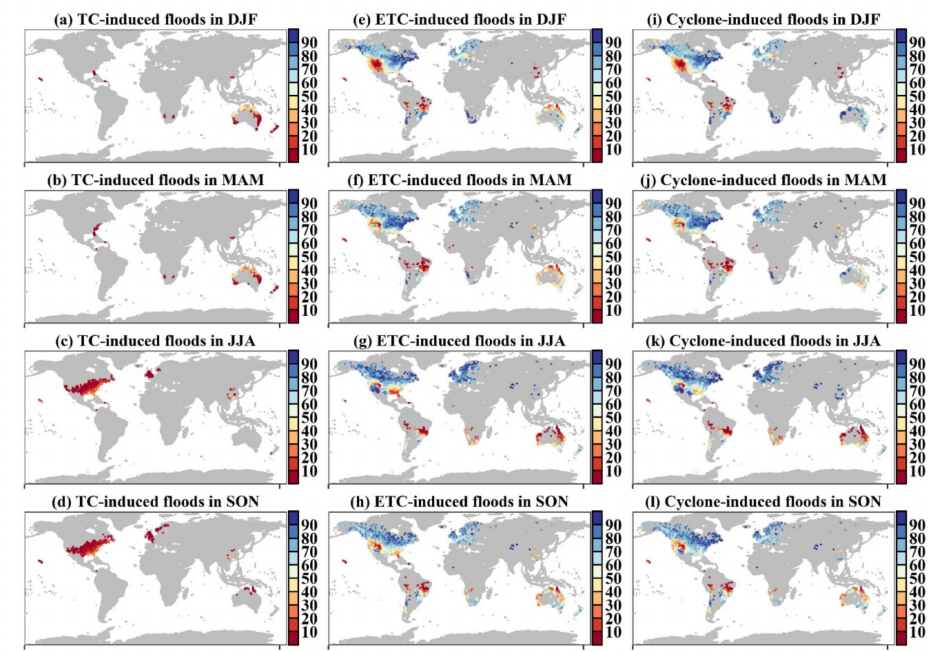
Figure 4. Contributions (%) of tropical cyclones (TCs, a – d ), extratropical cyclones (ETCs, e – h ), and all cyclones ( i – l ) to seasonal floods in observations sampled by block maximum (BM) method. The four seasons are DJF (December–February), MAM (March–May), JJA (June–August), and SON (September–November).